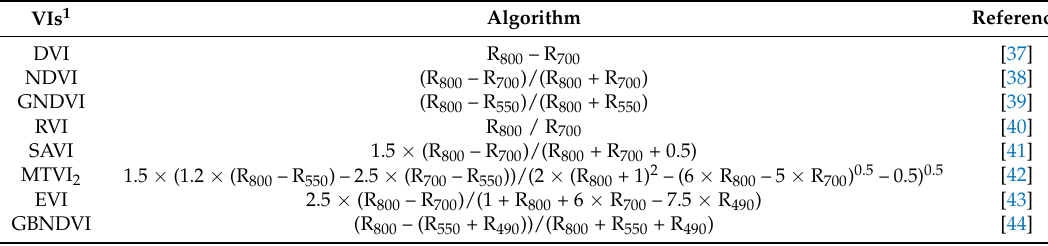
Table 5. The formulas for the vegetation indexes